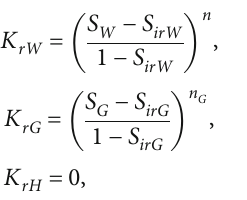
Figure 3: Evolution of the hydrate saturation distribution S = 0 : 30 , S = 0 : 05 , and P = 0 : 1 MPa S 0 irW irG